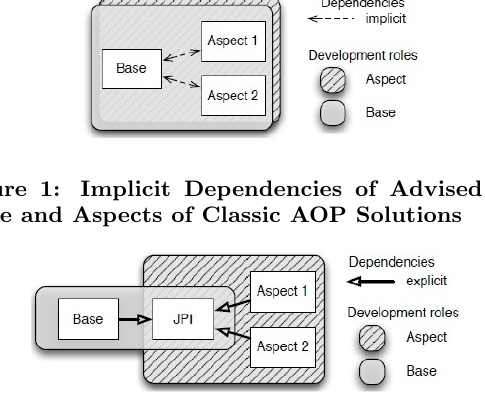
Figure 2: Dependencies of Base Code and Aspects with JPI Solutions